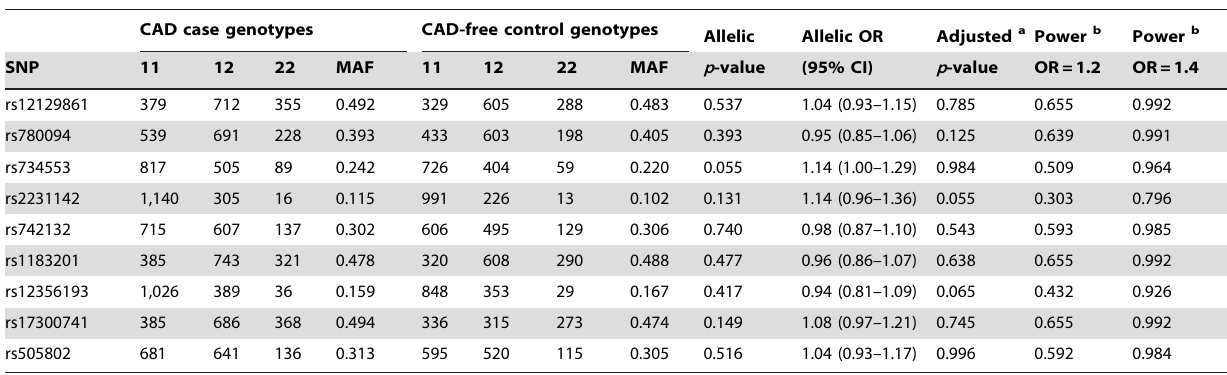
Table 7. Association analysis results in CAD case-control sample.